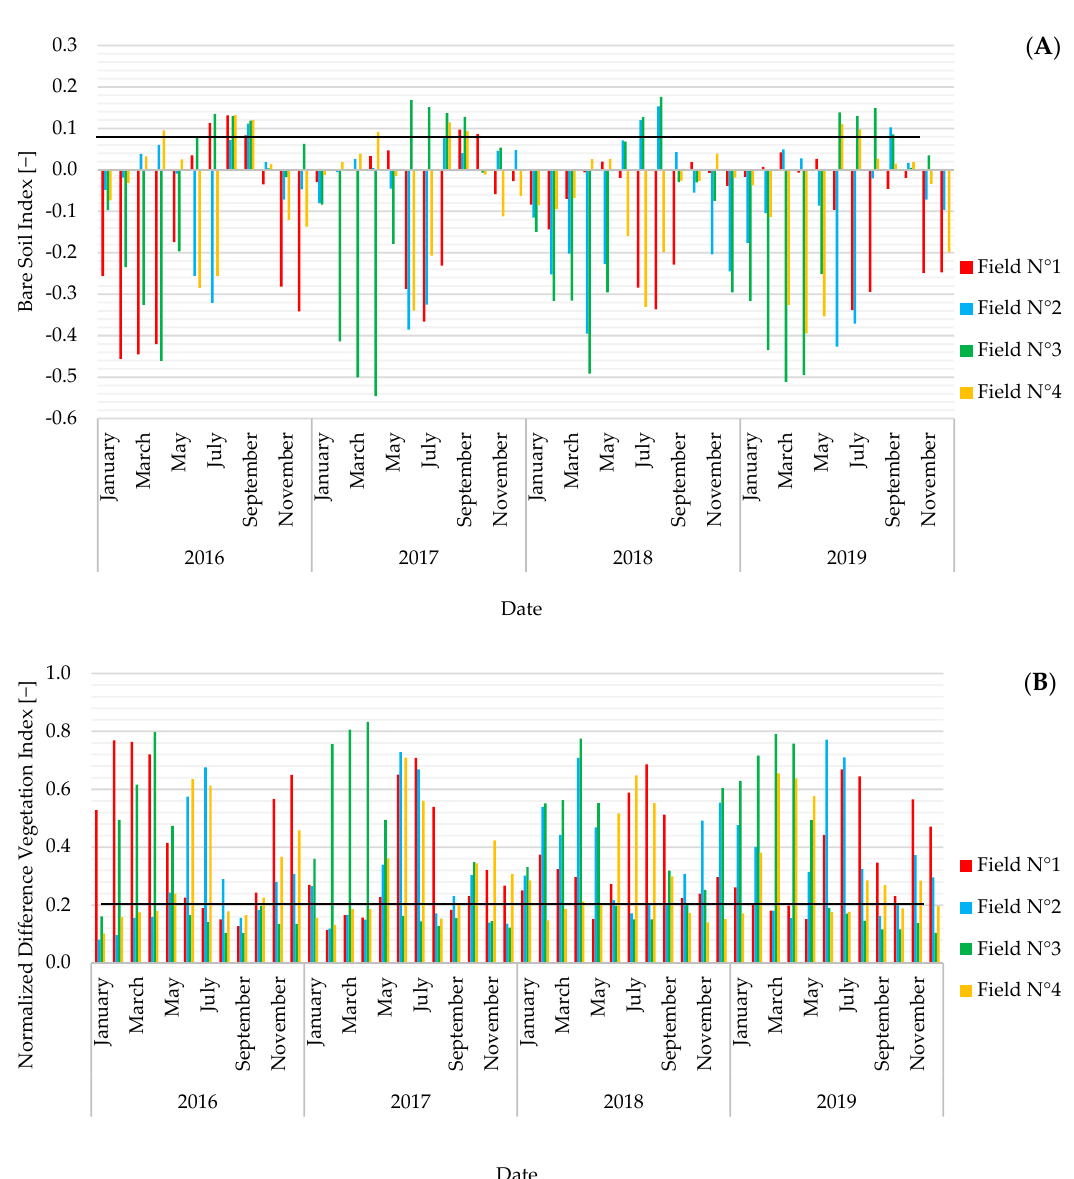
Figure 5. ( A ) Bare Soil Index (BSI) and ( B ) Normalized Difference Vegetation Index values (NDVI) [ − ] for the pixels in the set of selected agricultural fields of the agricultural areas of Rome (Central Italy). The horizontal black lines show the selected thresholds.